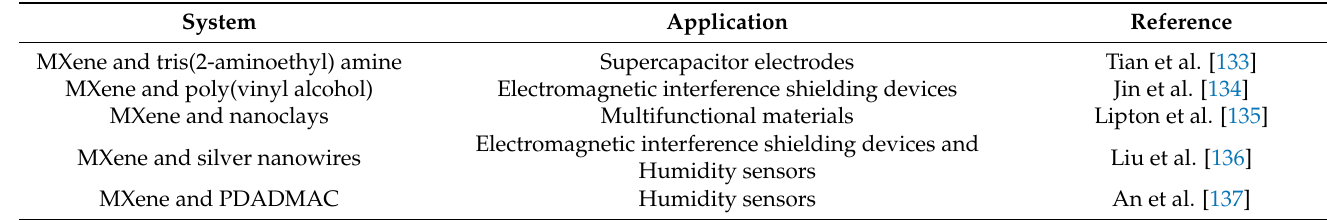
Table 3. Examples of LbL structures containing MXene and their potential